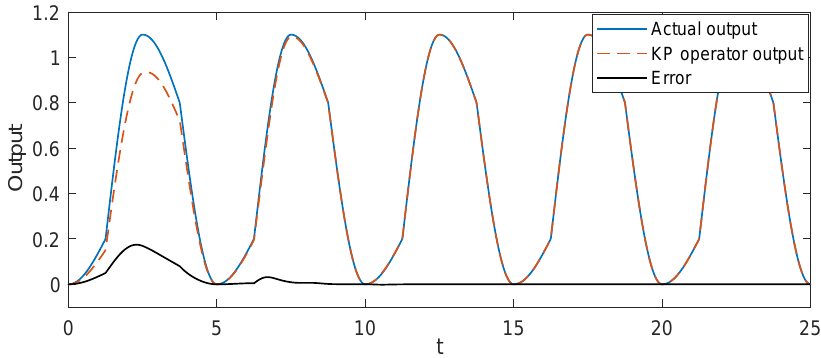
Figure 4. Simulation results of the KP model with the gradient descent algorithm under the sine wave voltage signal.